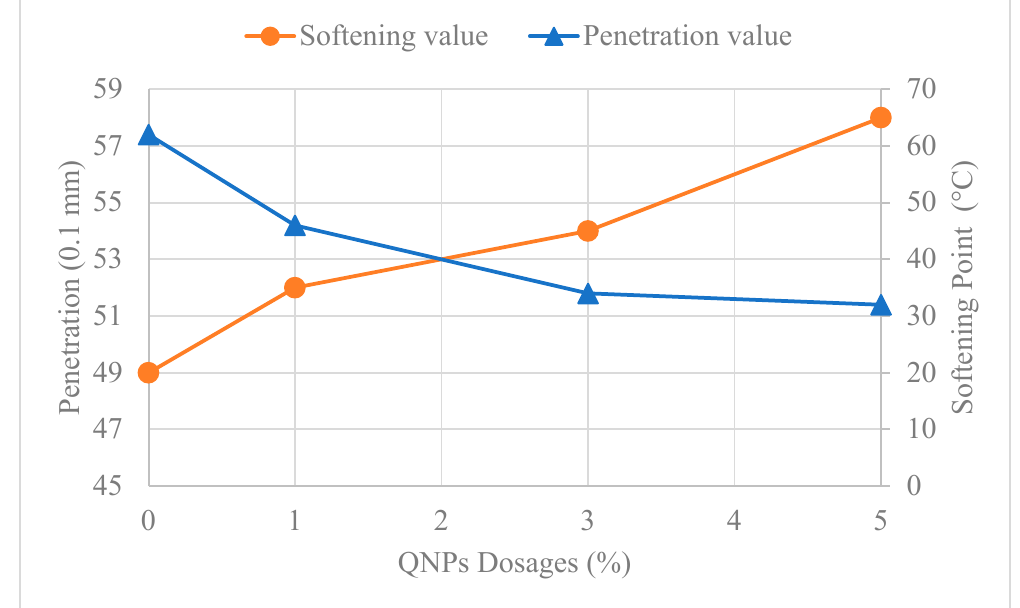
Figure 8. Influence of QNPs on penetration and softening values.